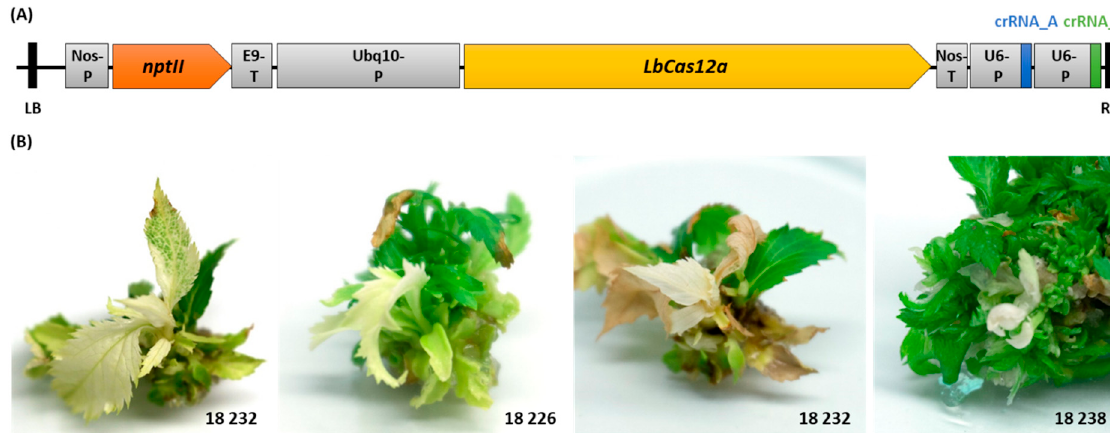
Figure 2. Transformation with the CRISPR/LbCas12a construct targeting MdPDS . ( A ) The T-DNA region of the binary plasmid p9oN-U10LbCpf1-Ex27 used for transformation of ‘Gala’ is shown. The T-DNA was flanked by left and right border sequences (LB and RB) and contained a neomycin phosphotransferase II ( nptII ) resistance cassette optimized for gene expression in plants that was under the control of the promoter from the nopaline synthase gene (Nos-P) and the rbcS-E9 gene terminator (E9-T). The promoter of the polyubiquitin 10 ( UBQ10 ) gene from A. thaliana (Ubq10-P) regulated the expression of the LbCas12a gene. Downstream of the LbCas12a gene is the terminator from the nopaline synthase gene (Nos-T). The expression of two crRNAs targeting the MdPDS loci A (exon 2) and D (exon 7) was driven by one A. thaliana U6 promoter (U6-P) each. ( B ) Examples of different regenerates resulting from T-DNA transformation with the CRISPR/LbCas12a construct containing shoots with albino tissue are